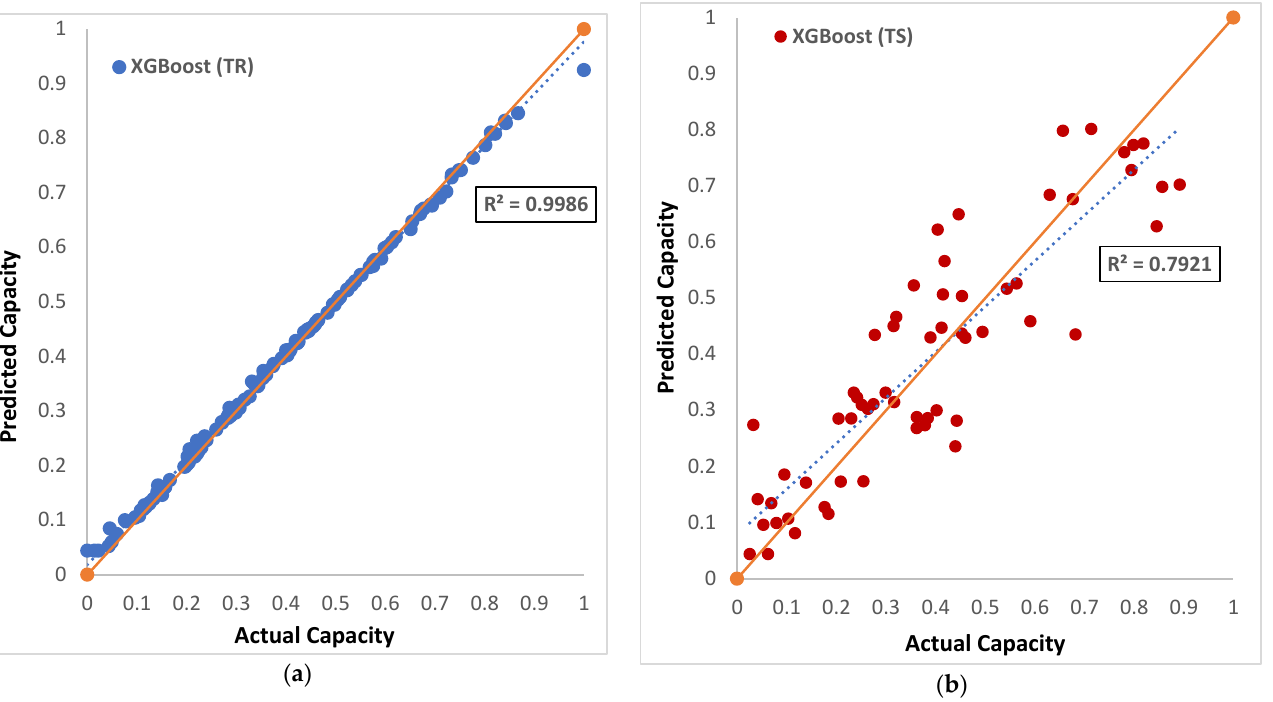
Figure 11. Trend for actual capacity and predicted capacity for XGB model: ( a ) training data; ( b ) testing data. Table 6. The value of different performance parameters for different machine learning techniques in predicting the group capacity of a training dataset.